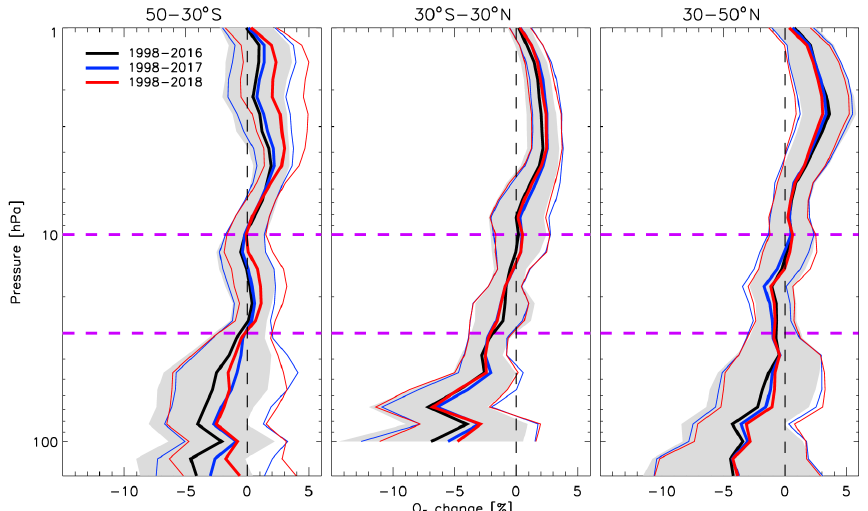
Figure 9. As for Fig. 8, but for the 50–30 ◦ S (SH), 30 ◦ S–30 ◦ N (tropics), and 30–50 ◦ N (NH)